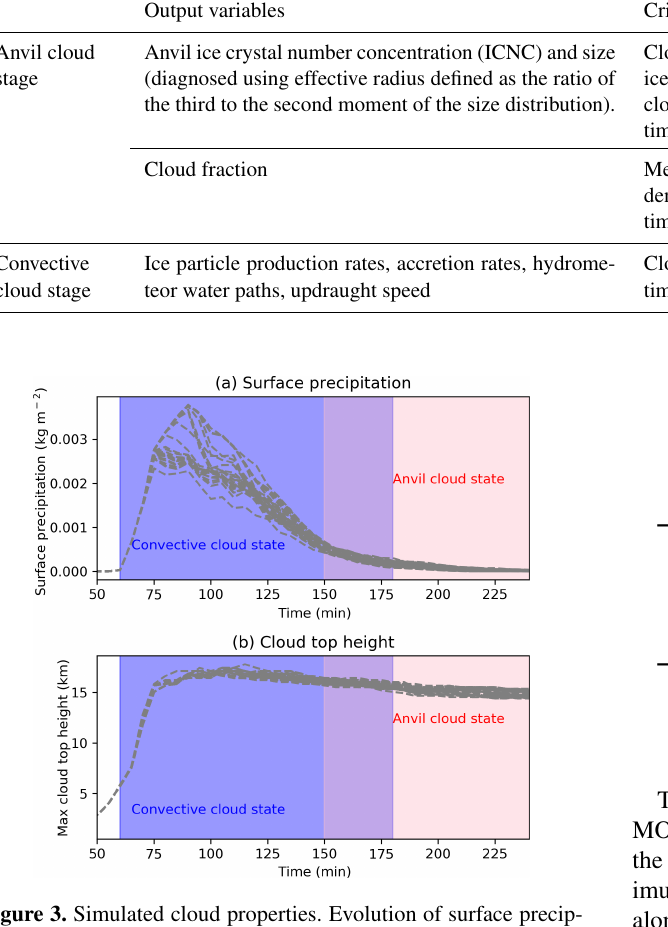
Figure 3. Simulated cloud properties. Evolution of surface precip- itation in all cloudy regions (a) and maximum cloud top height (b) over time for all simulations included in analysis. The convective and anvil cloud stages defined for the purposes of analysis are high-